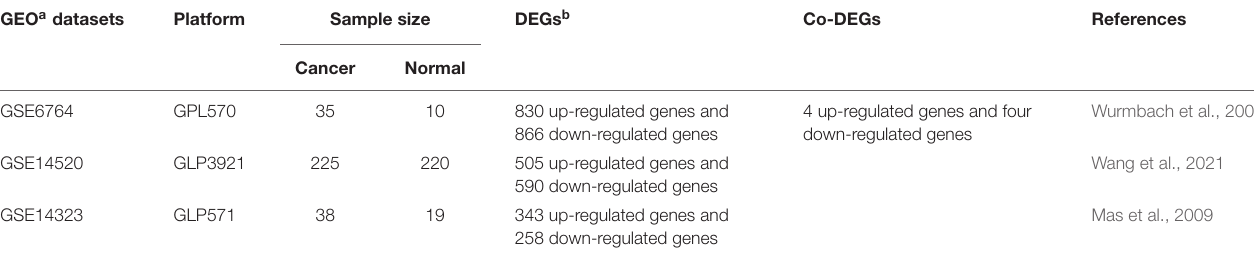
TABLE 1 | The primary characteristics of three GEO datasets on gene expression profiling via